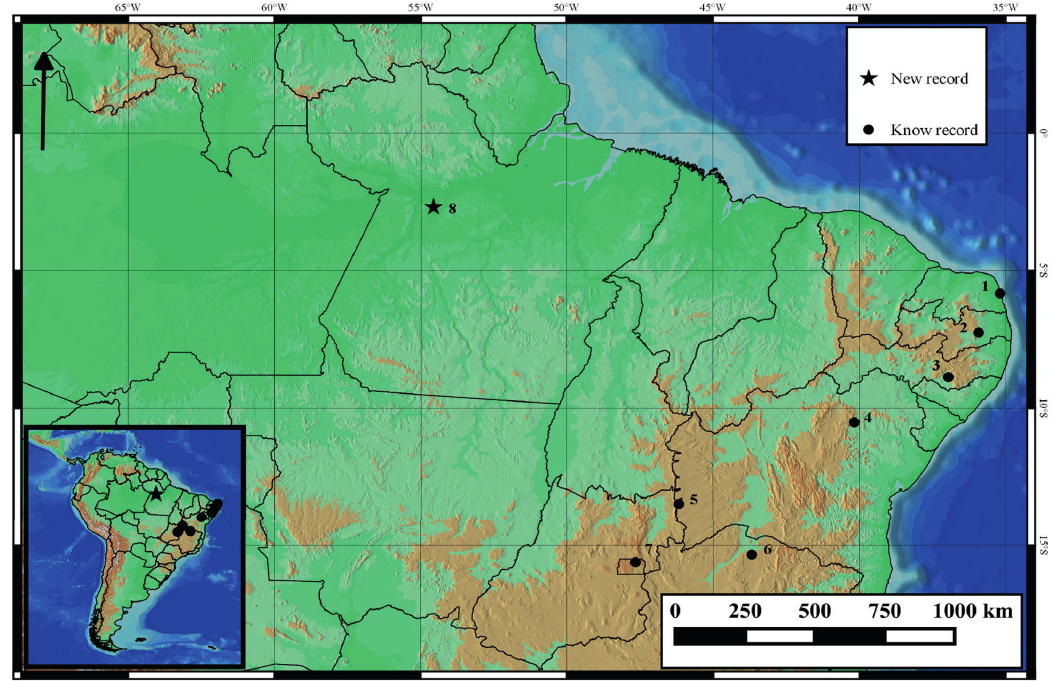
Figure 2 - Known geographic distribution of Utetheisa pulchella (linnaeus, 1758) in Brazil: 1) Natal (RN), 2) Campina Grande (PB), 3) (PE), 4) Senhor do Bonfi m (BA), 5) Correntina (BA), 6) Jaíba (MG), 7) Planaltina (DF), and 8) Mojuí dos Campos (PA), new